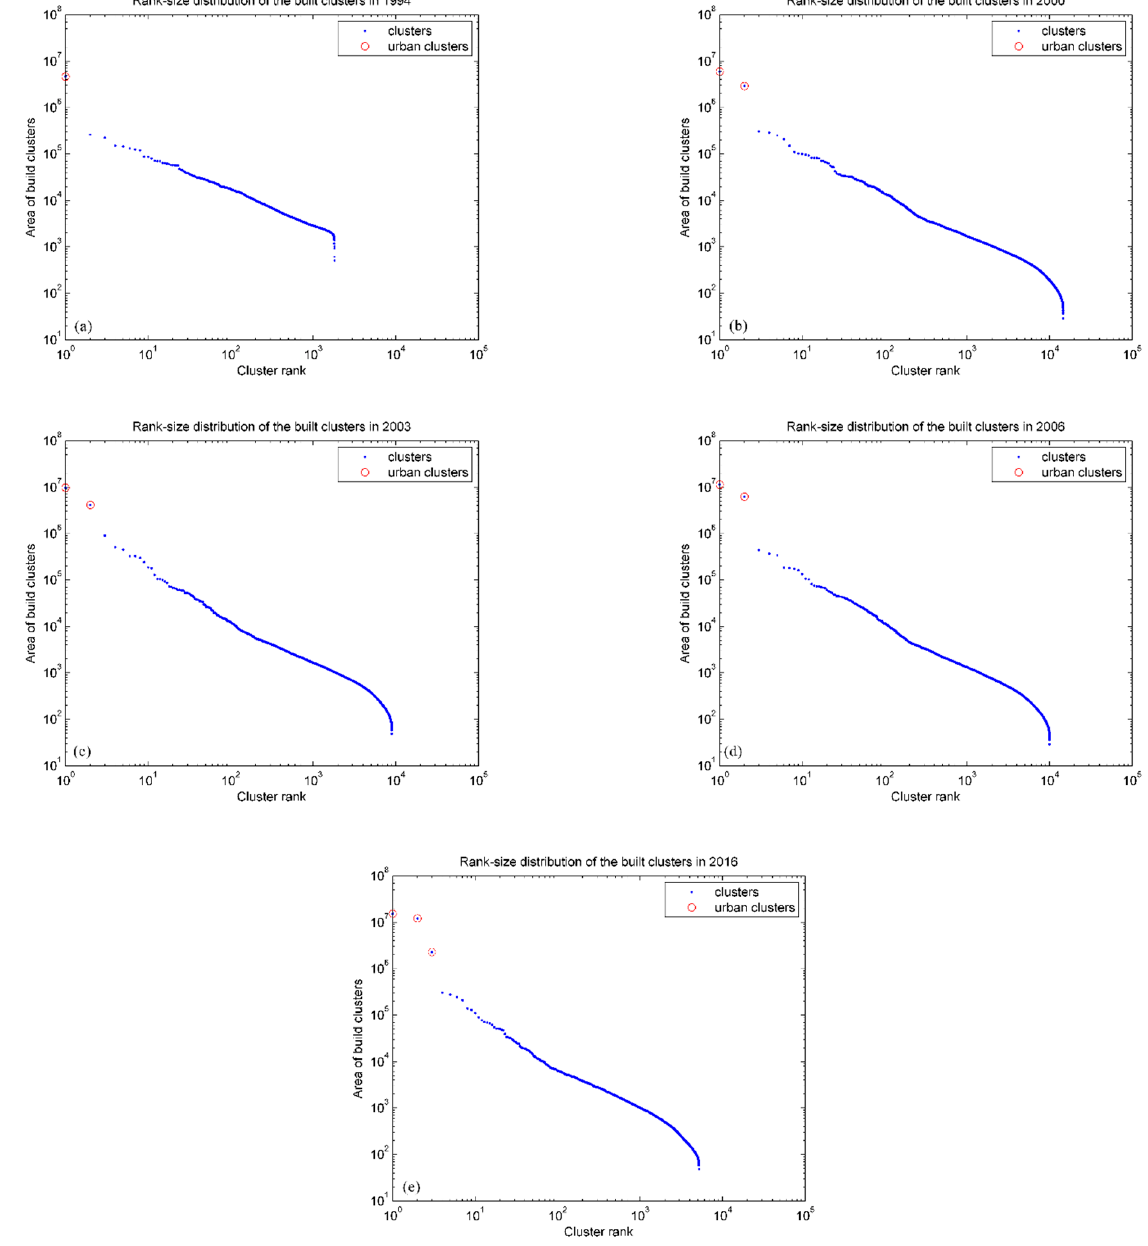
Figure 8. Results of rank-size distribution ( a – e ) from 1994 to 2016.